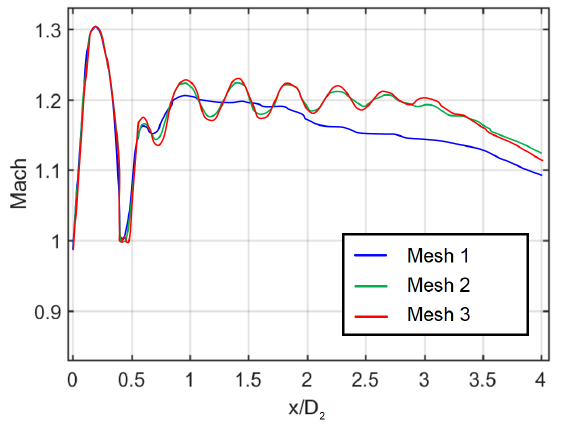
Figure 12. Comparison of“Physics Controlled” Mesh 1 and “User-defined” Mesh 2 and Mesh 3. Data have been extracted from the dashed line in Figure 13.